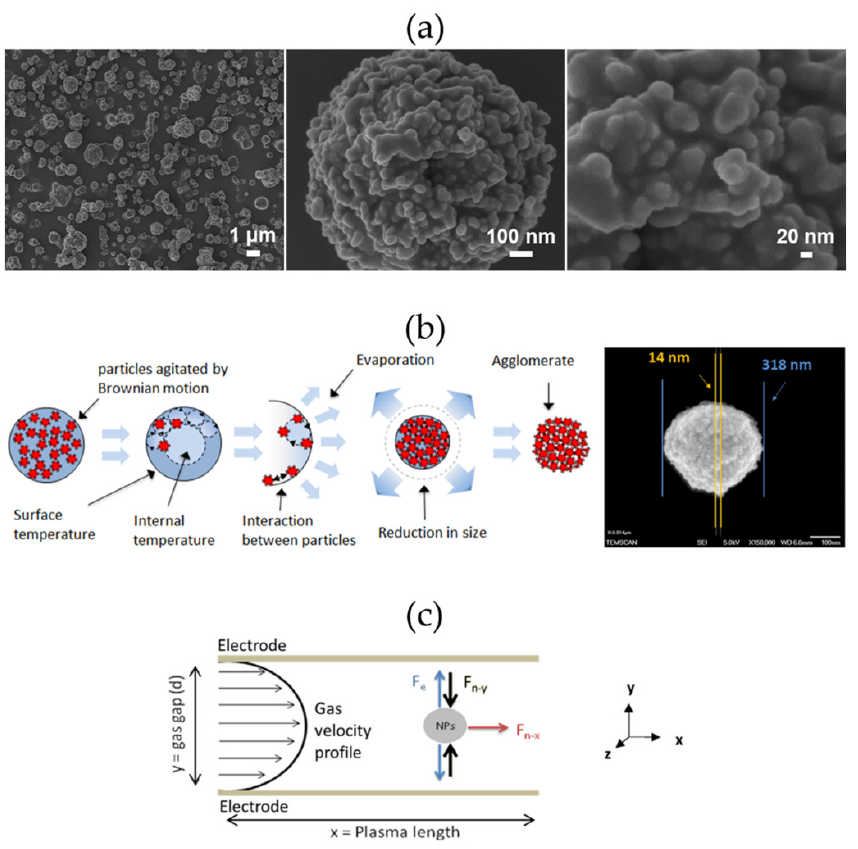
Figure 4. ( a ) Representative SEM images of a hydrocarbon polymer/ZnO NPs nanocomposite coating deposited for 10 min in a parallel-plate DBD fed with He and the aerosol of dispersion of oleate-capped ZnO NPs in n-octane. Reproduced with permission from [60]. ( b ) Schematic of the nebulization process explaining NPs agglomeration and SEM image of a NPs aggregate collected after atomization of a NPs dispersion. Reproduced with permission from [130]. ( c ) Schematic representation of the gas flow profile between the electrodes of a parallel-plate DBD system, and of the forces considered in [64] for the calculation of the NPs trajectory: F e is the electrostatic force, F n-x is the neutral drag force along the x-axis, F n-y is the neutral drag force along the y-axis. Reproduced with permission from